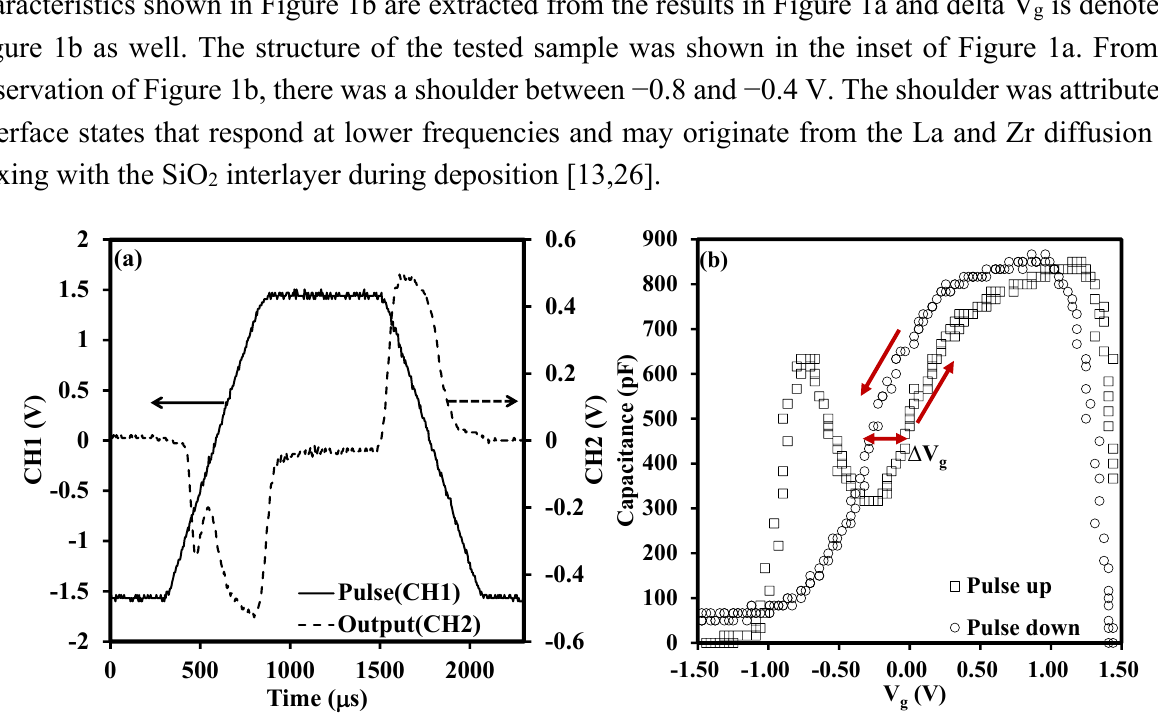
Figure 1. ( a ) Input, Channel 1 (CH1), and output, Channel 2 (CH2), signal for the pulse CV technique [3]; ( b ) CV characteristics of pulse up and pulse down extracted from ( a